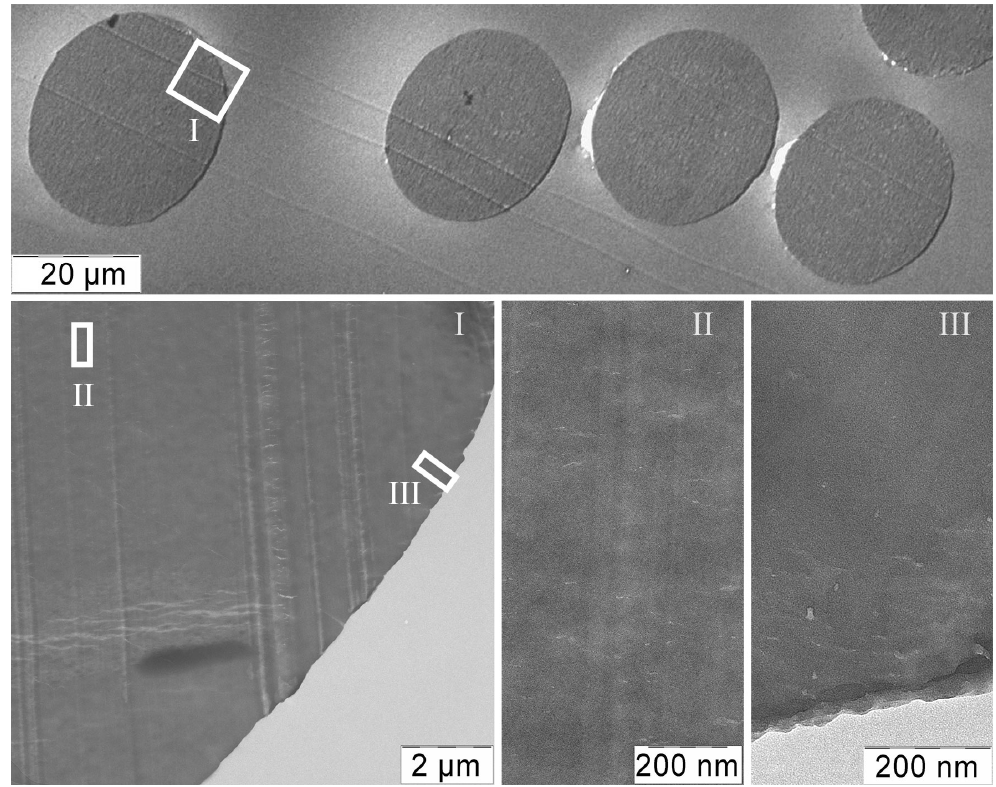
Figure 8. TEM images of PAN-MA1 fiber morphology (sample before orientation drawing). The arrow indicates the presence of a dense shell.